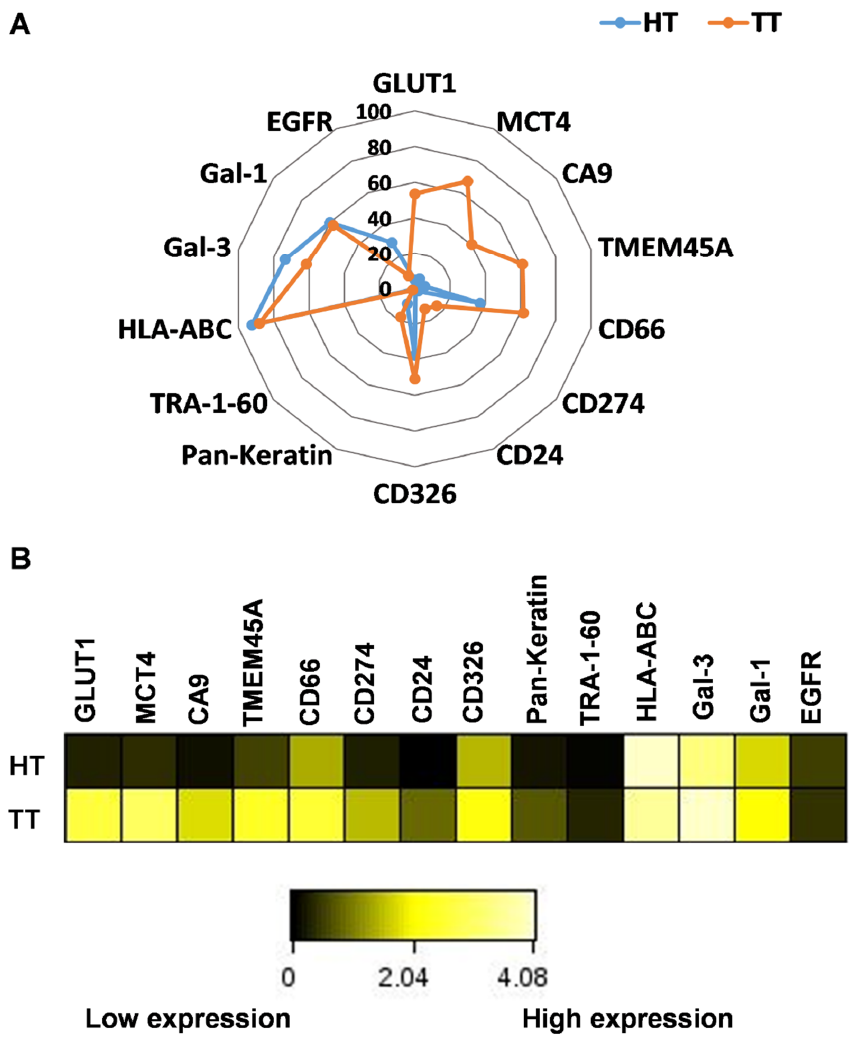
Supplementary Materials Table S5. Both tumor tissue (TT) and a small piece of healthy control lung tissue (HT) was excised during the surgical intervention and processed for mass cytometry in our laboratory within 1 h. Single cells were gated on 191 Ir+/ 193 Ir+ DNA intercalator double-positive events, as previously described [27]. We focused on tumor cells; therefore, the immune infiltrate was excluded by gating on anti-human CD45 − cells. The anti-HLA-ABC antibody was added to the panel, as diminished HLA-ABC expression can indicate the reduced immunosurveillance of tumors. The percentage of single cells positive for a given marker in TT vs. HT were the following: GLUT1 (53% vs. 4.8%), MCT4 (67.3% vs. 6.0%), CA9 (40.4% vs. 3.6%), TMEM45A (61.1% vs. 5.6%), CD66 (61.7% vs. 37.1%), CD274 (15.6% vs. 2.4%), CD24 (12.8% vs. 0.9%), CD326 (50.7 vs. 37.4%), pan-keratin (17.8% vs. 9.5%), TRA-1-60 (1.5% vs. 0.9%), HLA-ABC (88.1% vs. 92.4%), Gal-3 (61.5% vs. 73.6%), Gal-1 (57.7% vs. 60.1%), and EGFR (7.8% vs. 28.9%), respectively (Figure 6A). The positivity of cells for GLUT1, MCT4, CA9, TMEM45A, CD66, CD274, CD24, CD326, and pan-keratin were associated with TT, which allowed delineation—from those associated with HT—of tumor-specific trajectories on a radar plot.